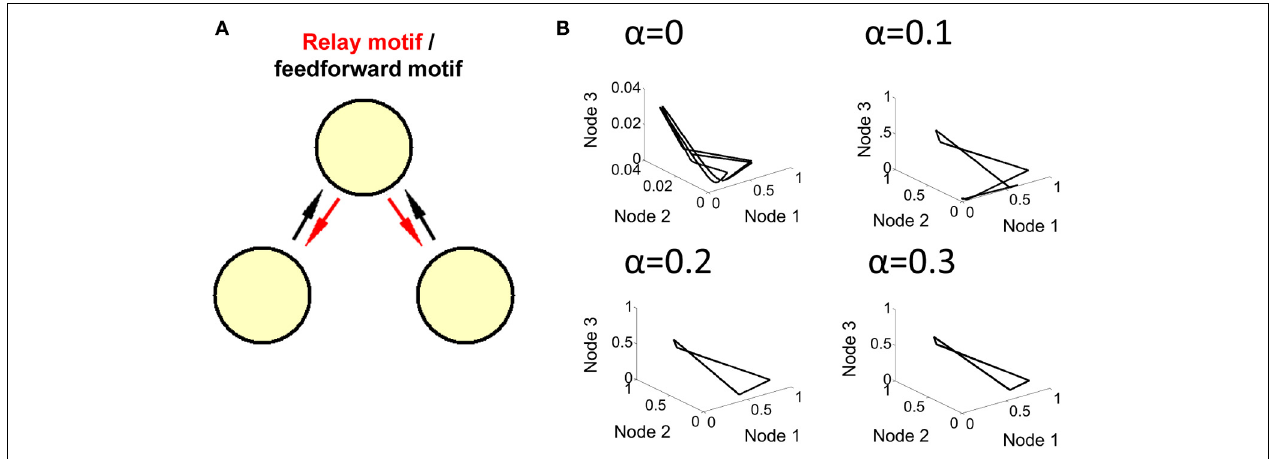
FIGURE 5 | Transition to limit cycle activity. (A) By adjusting a single parameter α in the model (Equation 1), we can alter the strength of connections in red, generating either a feedforward network (when α = 0), or a relay network (when α > 0). (B) By setting the value of α to either 0, 0.1,